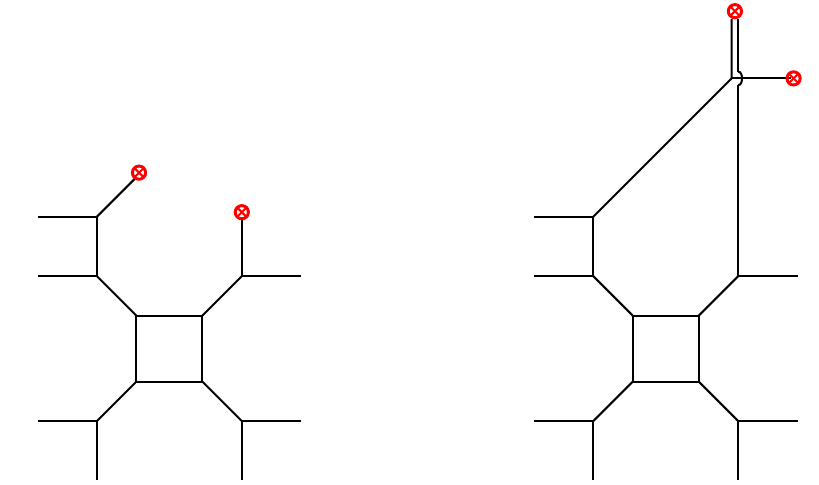
Table 5 . BPS Spectrum of the BPS sector F and d 2 ≤ 7 .